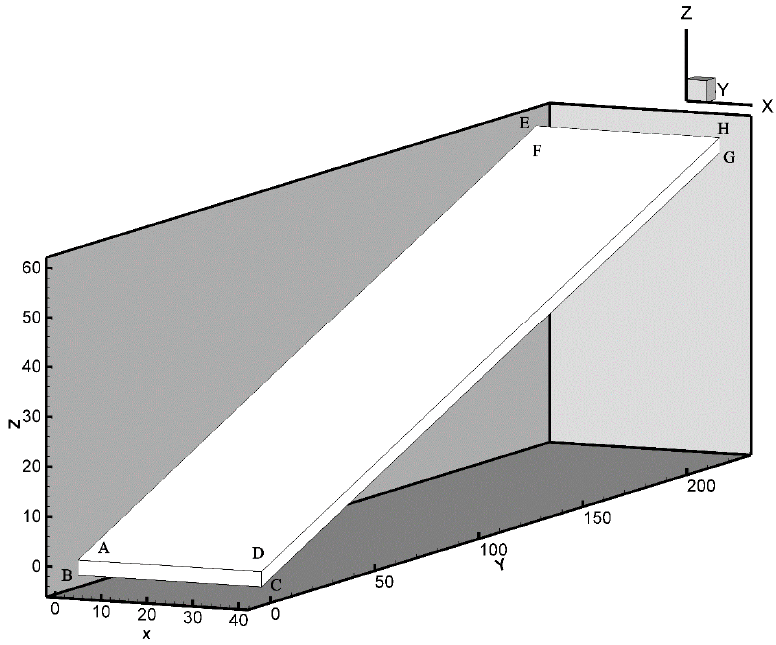
Figure 1. The schematic representation of the 200 m slope used the InHM modeling, and A-H represents each of the boundary nodes.